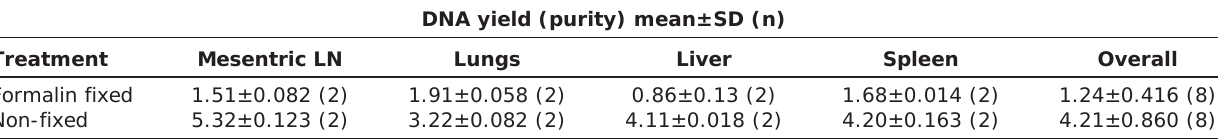
Table-1: Analytical DNA yield in mesenteric lymph node, lungs, liver and spleen, expressed as μ g DNA/mg of tissue. Fixation time of 3 days followed by conventional method extraction. DNA yield (purity) mean±SD (n)